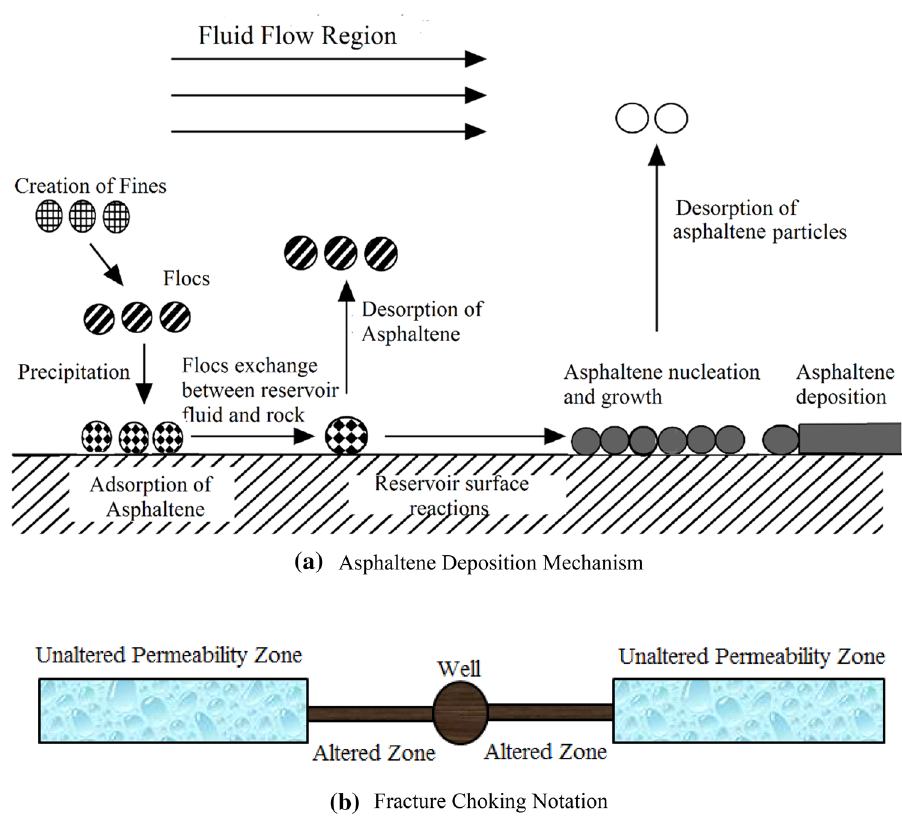
Fig. 2 Schematics of fracture choking due to asphaltene